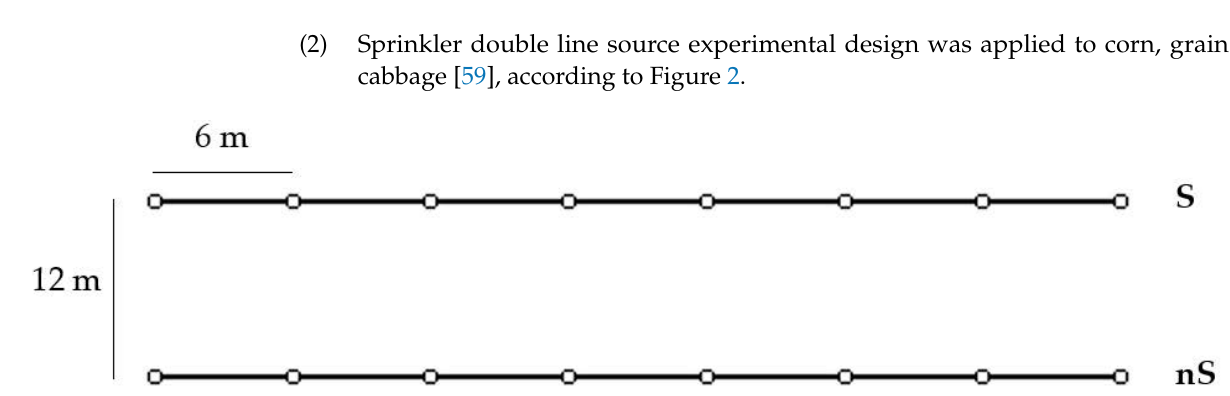
Figure 2. Experimental plot layout of the double line source irrigation system designed to produce saline gradients (o—sprinkler; S—saline water (EC w = 12 dS m − 1 ); nS—fresh water (EC w = 1 dS m − 1 ).